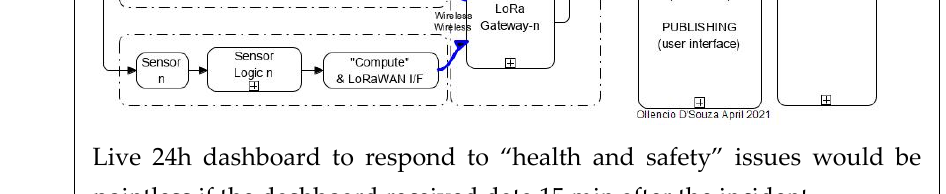
Figure 31. Schematic drawing shows the path of sensor data through infrastructure which could result in loss of temporal sync.